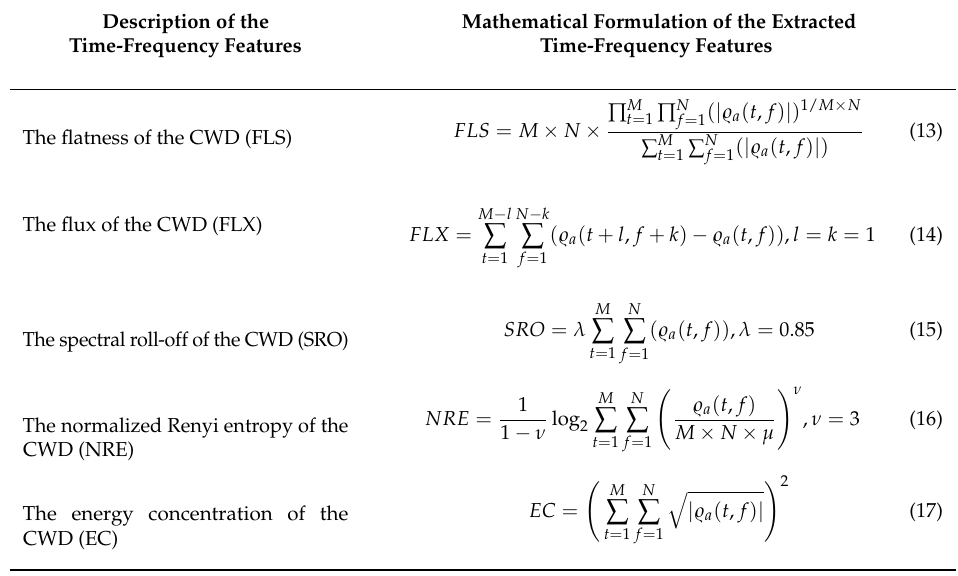
Table 3. The extracted time-frequency features obtained by extending five frequency-domain features to the joint